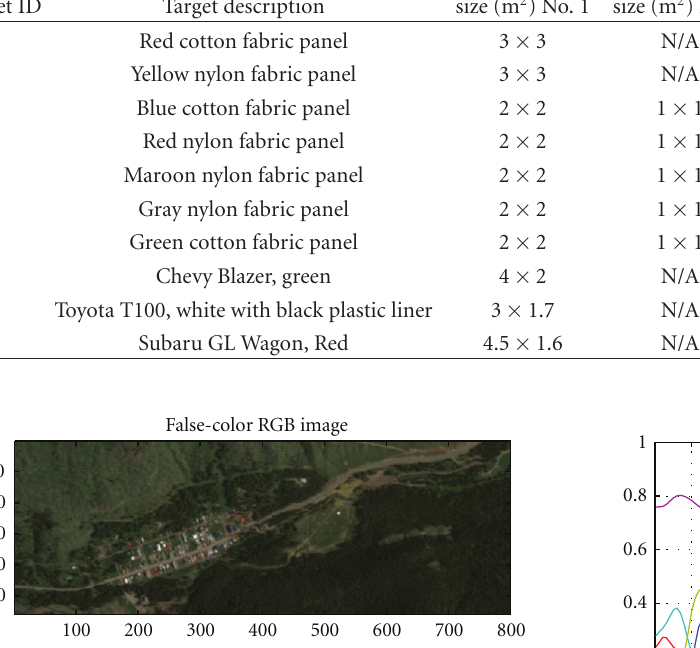
Figure 2: False-color RGB of the Cooke City imagery.